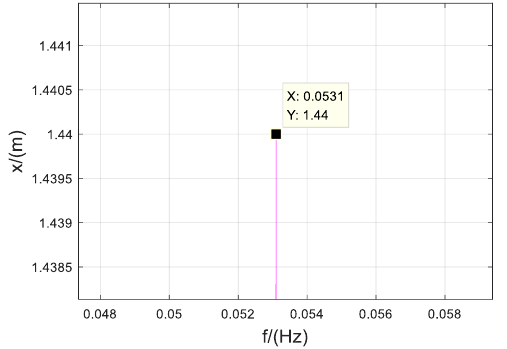
Figure 15. Spectrum diagram.